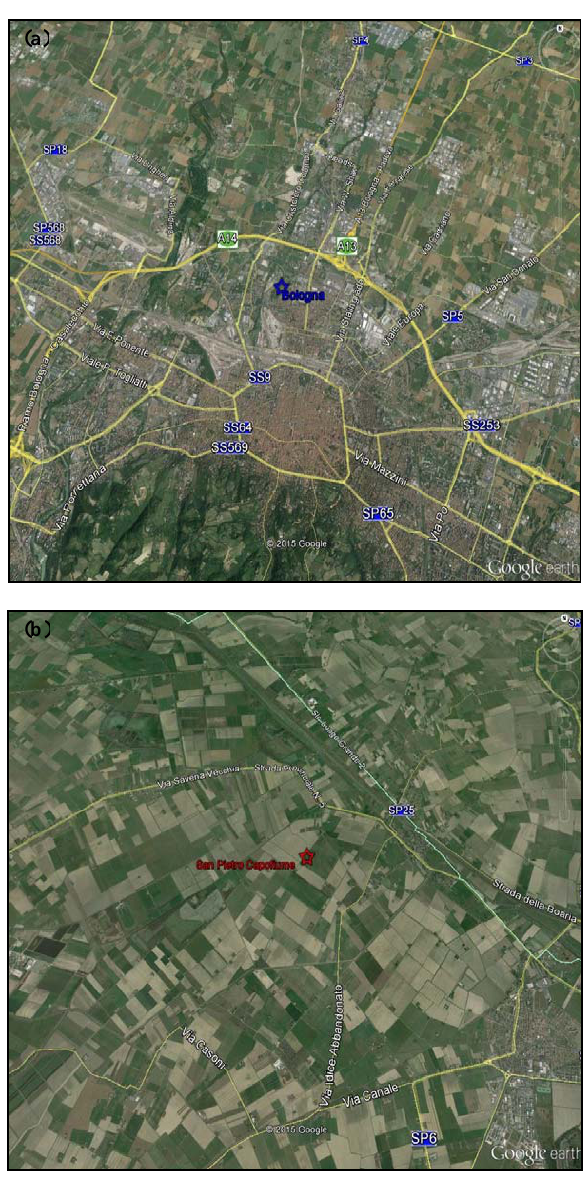
Figure 1. Maps created using Google Earth (version 7.1.5.1557) to show the areas surrounding the (a) Bologna and (b) SPC sampling sites.